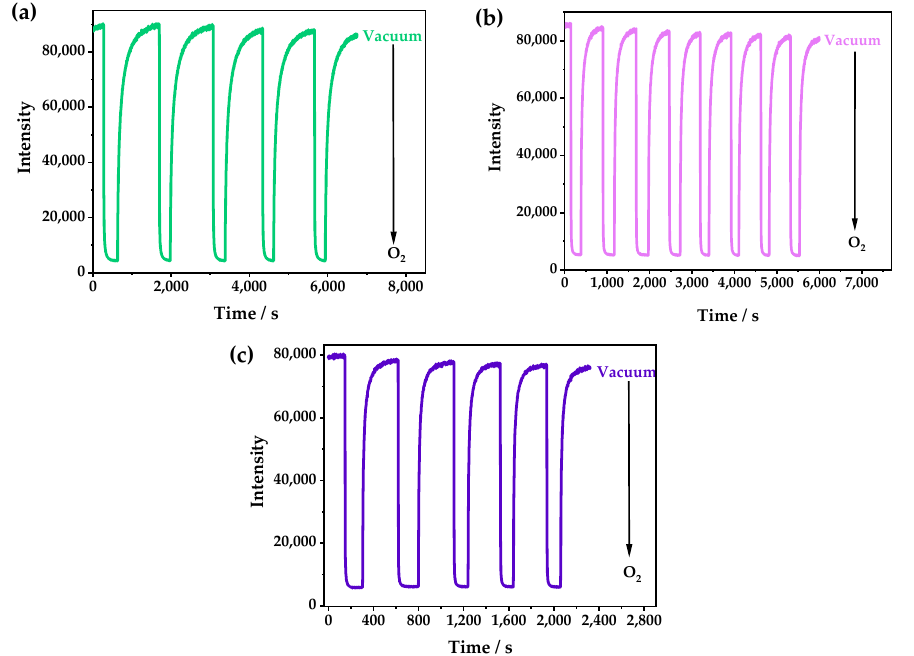
Figure 5. The time-dependent spectra of 1 at ( a ) 333, ( b ) 353, and ( c ) 373 K when switching between a vacuum and 1 bar O 2 —excited by 365 nm UV light and detected at 542 nm.